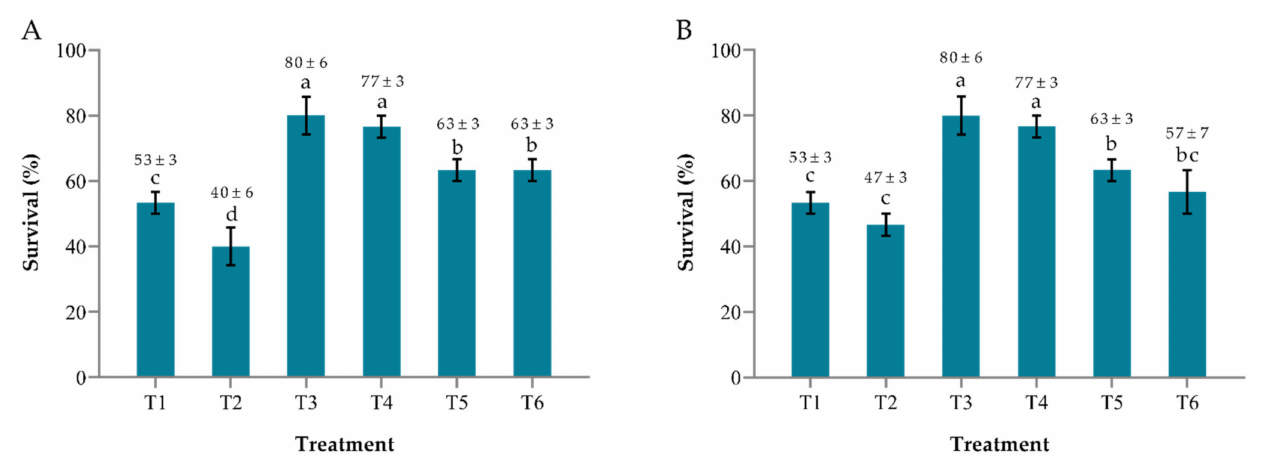
Figure 1. The survival percentage of Moina micrura after being treated with Bacillus pocheonensis at different concentrations and challenged with ( A ) Streptococcus agalactiae and ( B ) Aeromonas hydrophila at 10 5 CFU mL − 1 . T1 ( M. micrura + C. vulgaris ); T2 ( M. micrura + C. vulgaris + pathogen); T3 ( M. micrura + C. vulgaris + B. pocheonensis at 10 4 CFU mL − 1 ); T4 ( M. micrura + C. vulgaris + B. pocheonensis at 10 6 CFU mL − 1 ); T5 ( M. micrura + C. vulgaris + B. pocheonensis at 10 4 CFU mL − 1 + pathogen); T6 ( M. micrura + C. vulgaris + B. pocheonensis at 10 6 CFU mL − 1 + pathogen). Each value is the mean ± SEM of triplicate analysis. a,b,bc,c,d bars and mean with different alphabetical letters indicate a statistically significant difference (One-way ANOVA, p <